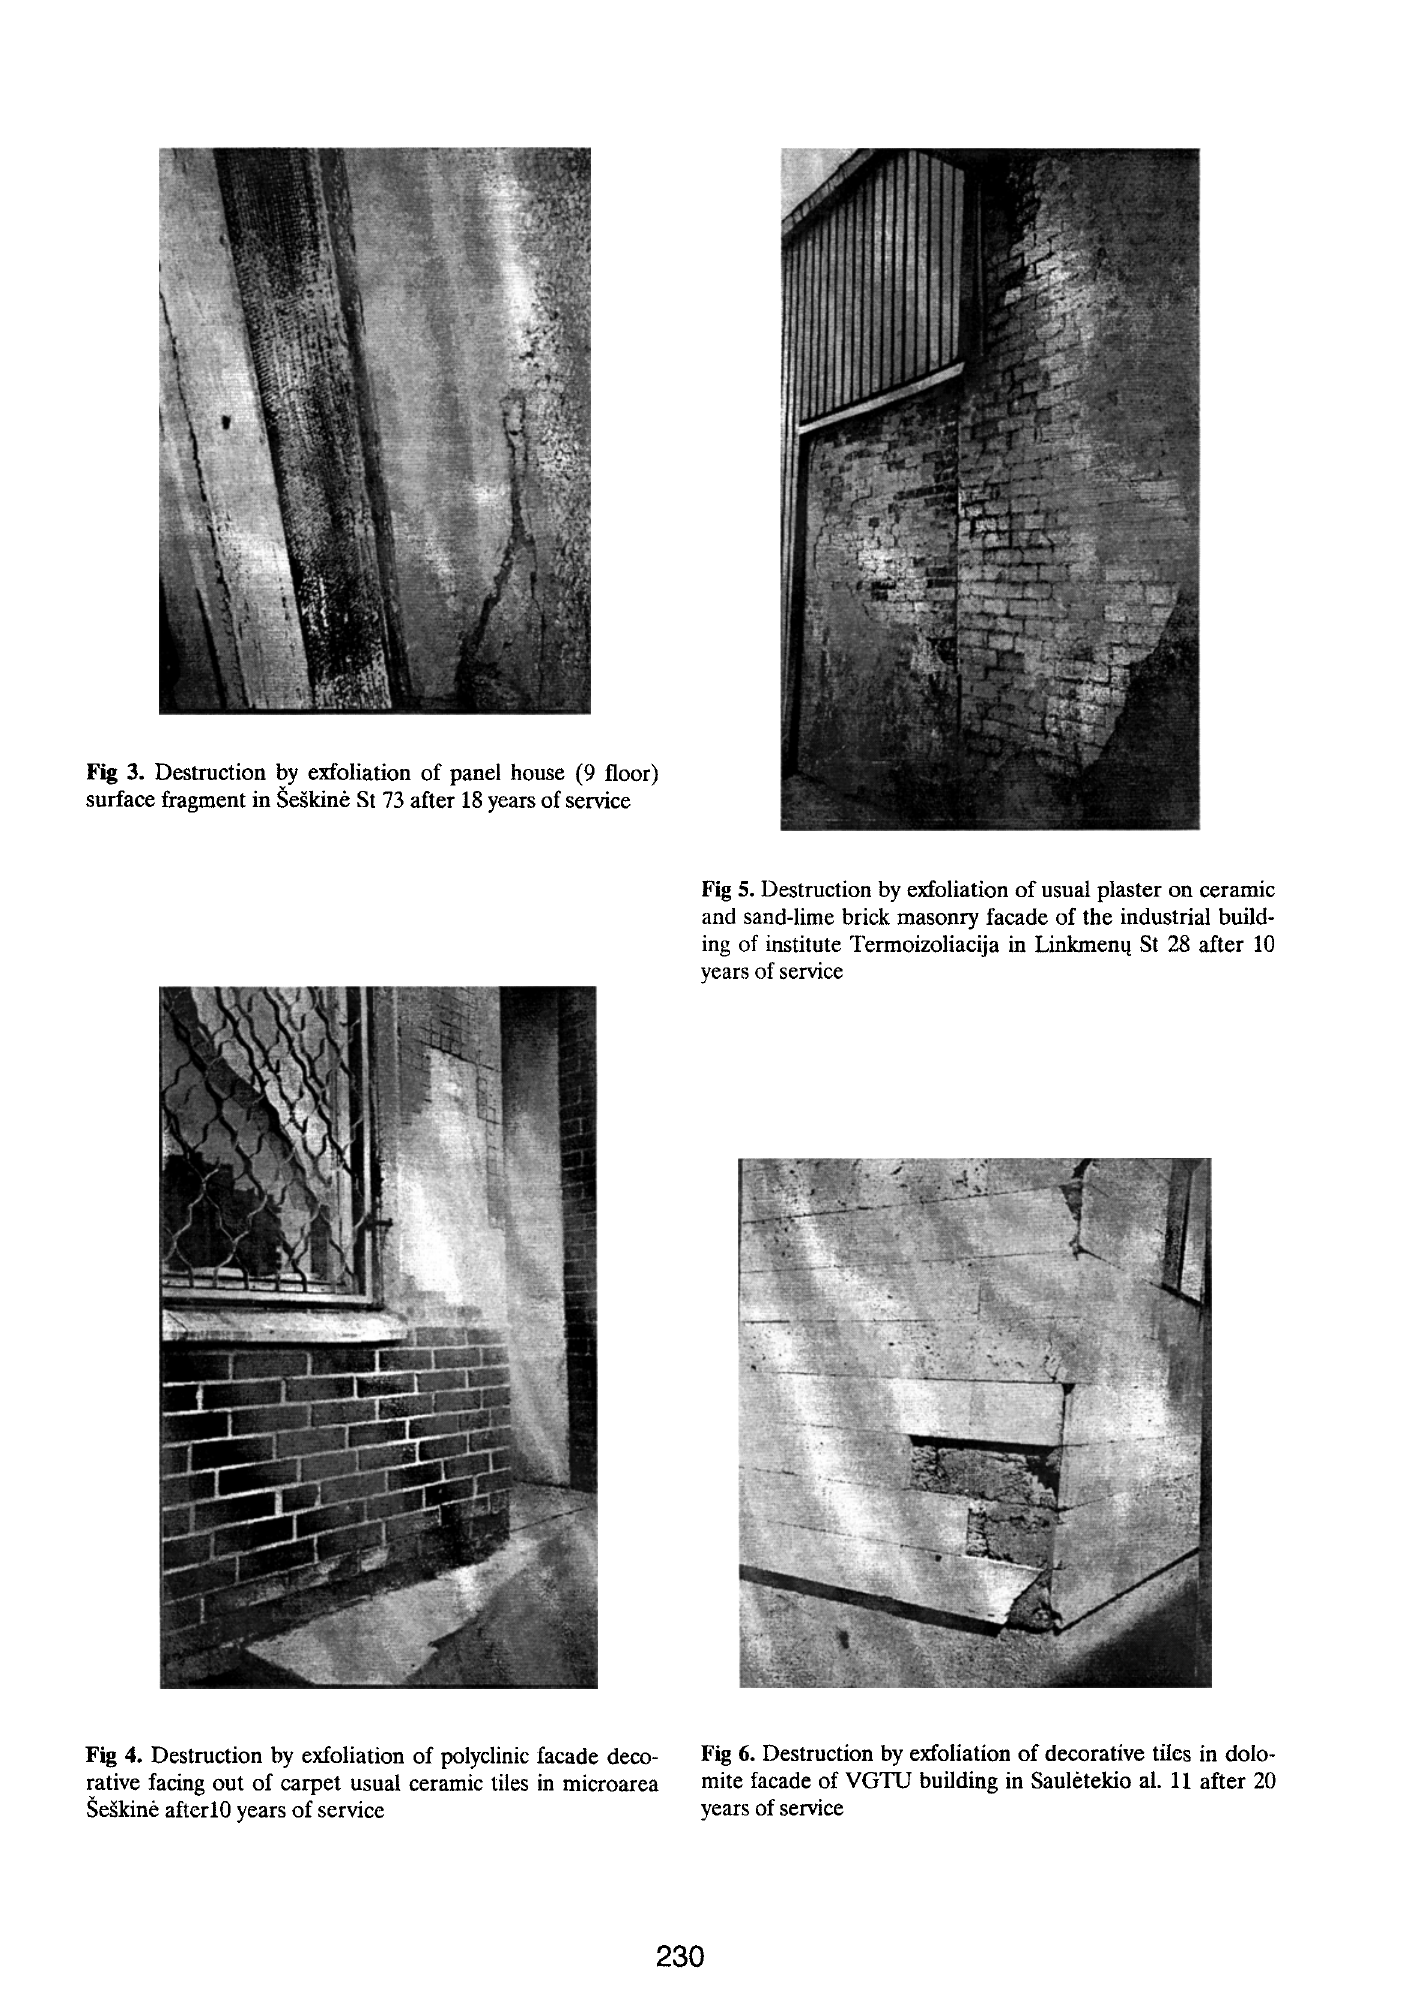
Fig 3. Destruction by exfoliation of panel house (9 floor) surface fragment in Se~kine St 73 after 18 years of service